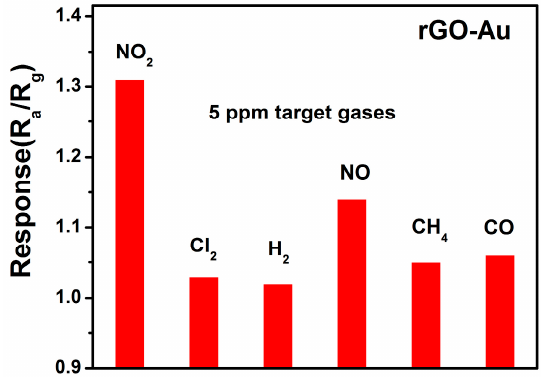
Figure 8. The responses of rGO/Au based sensor to 5 ppm of different gases at 50 °C.